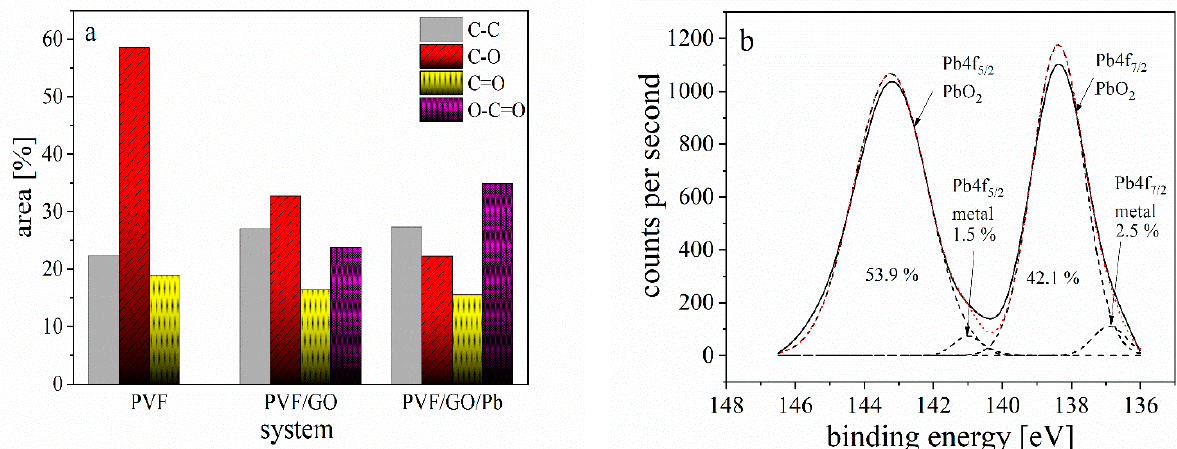
Figure 3. Relative area under the peaks for PVF polymer, the PVF/GO and the PVF/GO/Pb composite. ( a ). XPS spectra of the Pb4f peak of PVF/GO/Pb composite. ( b ). The solid line represents the experimental data. The dashed lines represent the individual contributions. The dotted line is a fit of a sum of four Gaussians to the data.